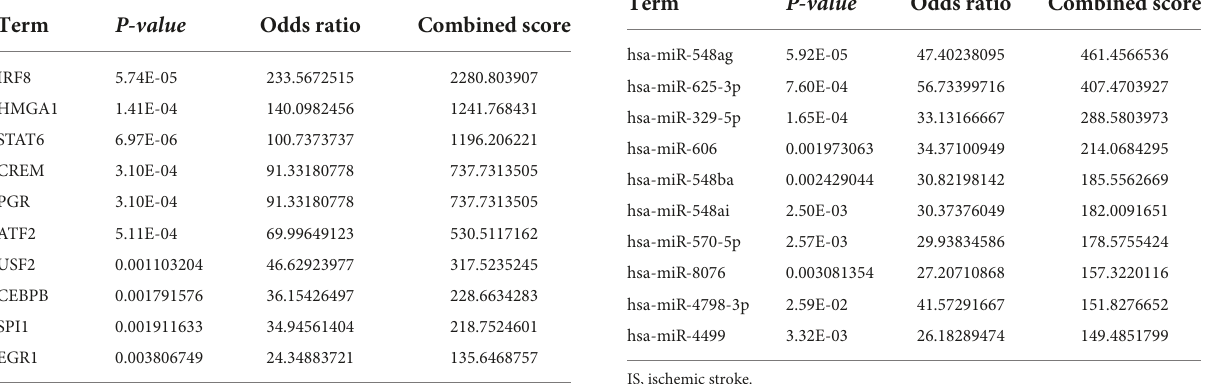
TABLE 1 Transcriptional factor targets of 21 ferroptosis-related genes in IS.